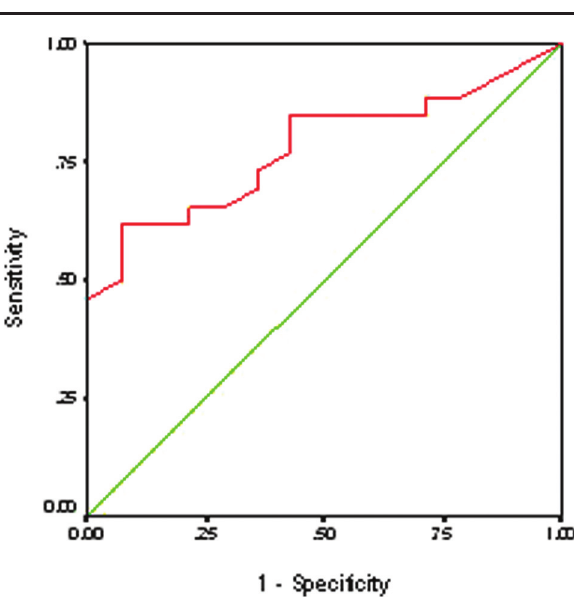
Saint George Respiratory Questionnaire as a better positive than negative predictor